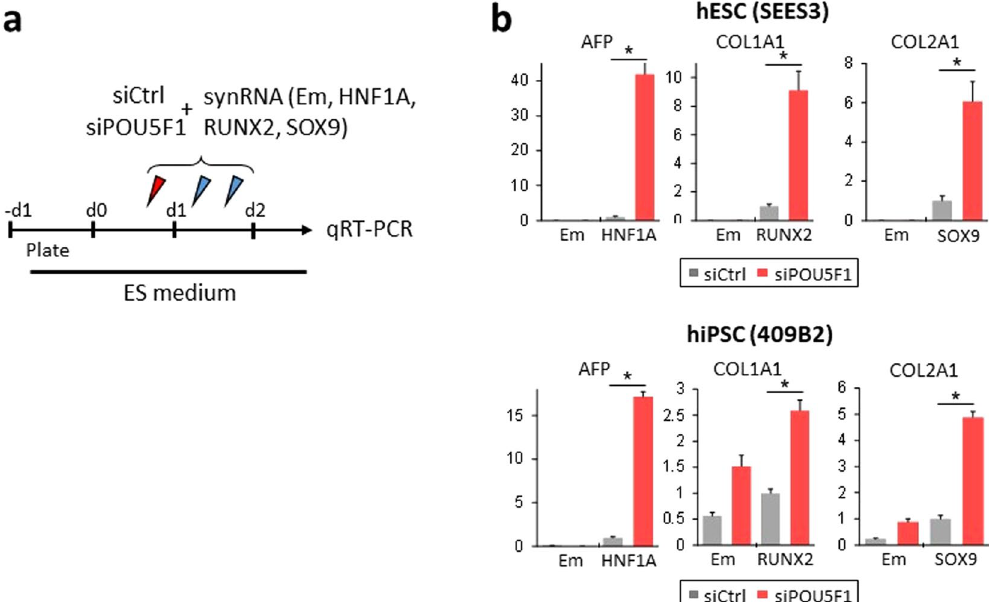
Figure 7. siPOU5F1 facilitates the upregulation of relevant tissue-specific markers mediated by other transcription factor synRNAs. ( a ) Experimental schematic for ( b ). hESC/iPSCs were transfected with siCtrl or siPOU5F1 and synRNAs for HNF1A, RUNX2, and SOX9 at the indicated time points. Emerald synRNA was used as a control. A mixture of siRNA and synRNA was transfected on the first day. On day 2, only synRNA was transfected twice. The cells were cultured in ES maintenance medium and sampled for qRT-PCR analysis on day 2. ( b ) Relative gene expression levels of tissue-specific genes (AFP, COL1A1, and COL2A1) in hESCs (SEES3) and hiPSCs (409B2) transfected with siCtrl or siPOU5F1 and synRNA. The transfected synRNA of transcription factors are indicated on the horizontal axis. Em indicates Emerald synRNA. The expression levels were normalized against that of GAPDH. Error bars indicate SEM (n = 3). * P < 0.05,